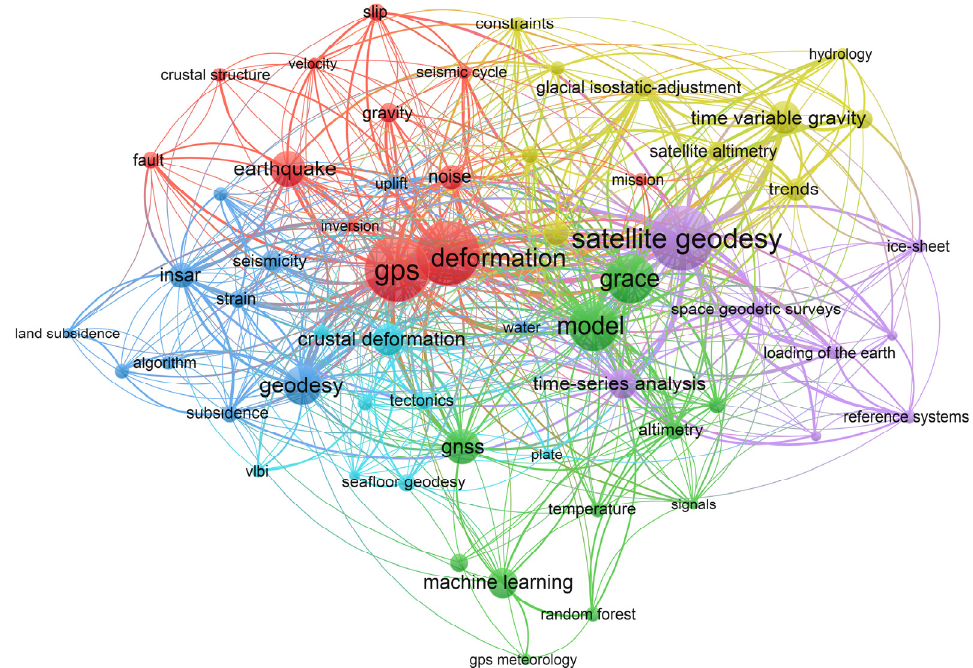
Figure 2. The network of the co-occurrence keywords retrieved from the selected journals displayed in Figure 1. Note that we set the limit of the connections threshold in order to present only the 14 highest ranked words.